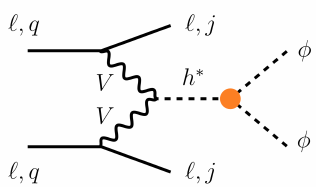
Figure 1: Feynman diagram for the signal studied in this work. The orange dot represents either of the portals in Eqs. (1) and (2).